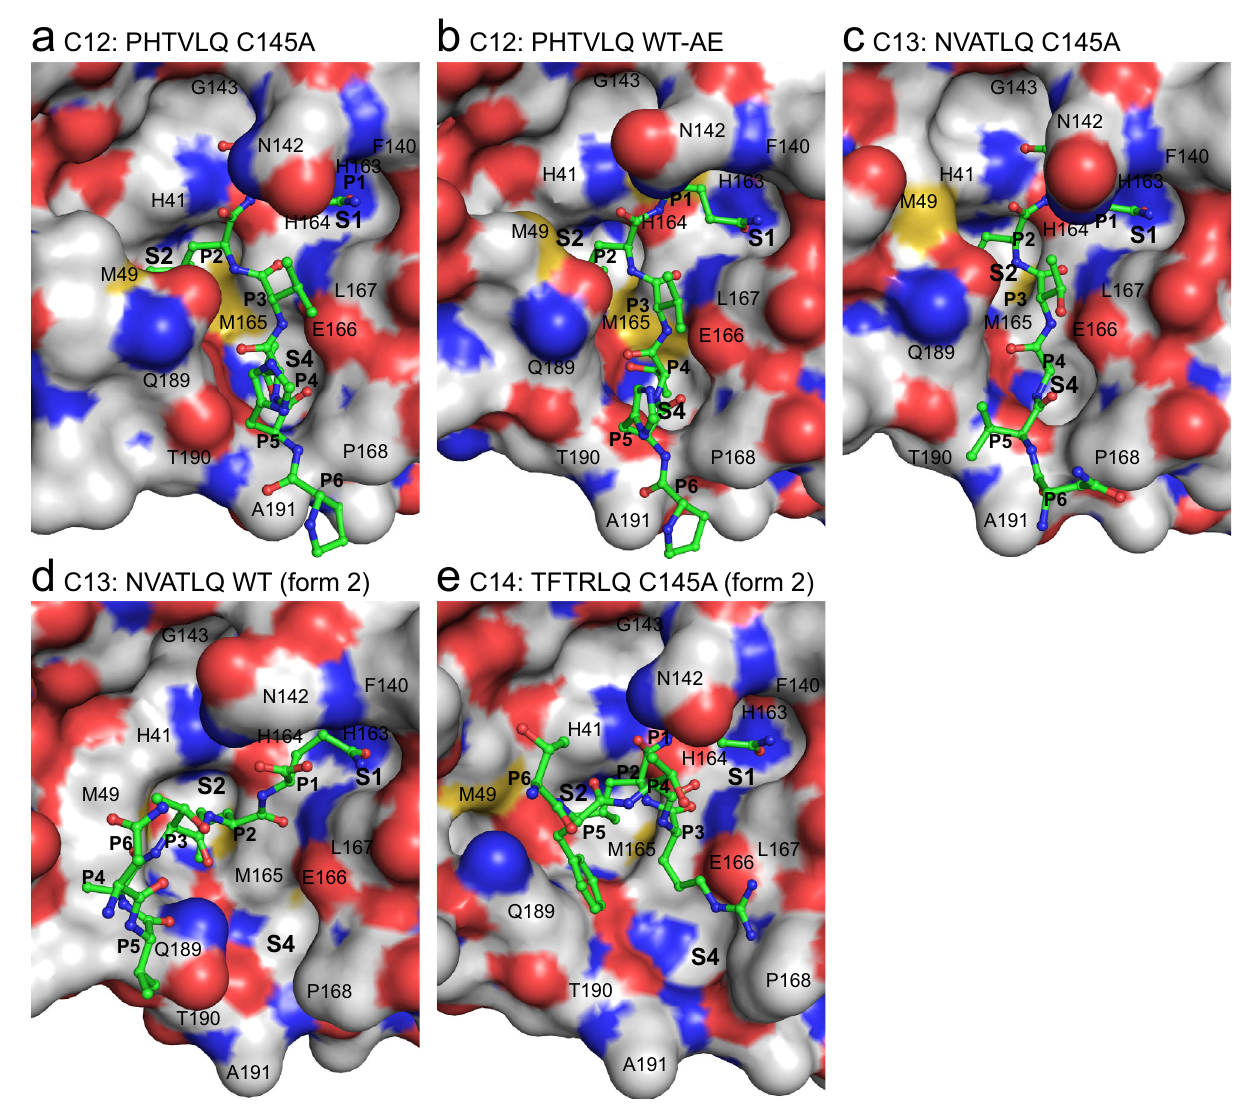
Fig.3|X-raycrystallographicstructuresofSARS-CoV-2M pro cleavagesitesC12toC14.a and c – e showproduct-likecomplexeswiththeC145Amutant, b showsanacyl- enzyme (AE) intermediate complex with wild-type (WT) M pro . Labels and colors as in Fig.